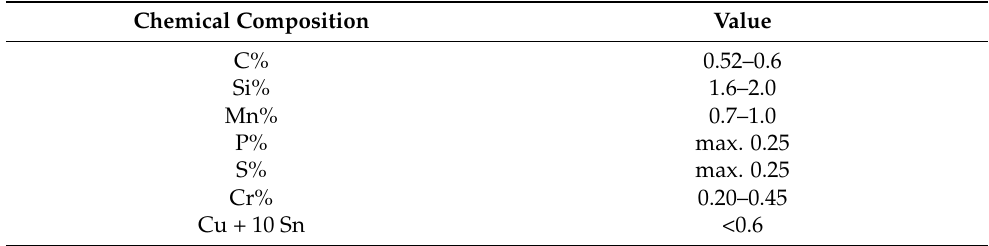
Table 4. Chemical composition of the pin’s alloy % (56SiCr7, in accordance with SR EN 10089:2003